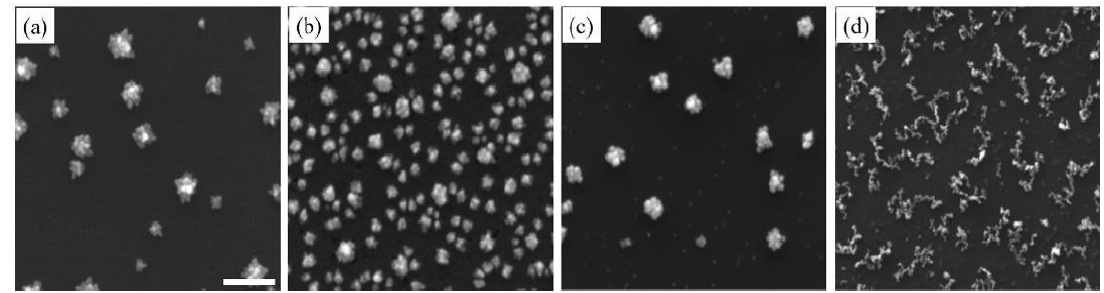
Figure 3. SEM images of Pd nanostructures deposited on Si substrate after the ( a ) first and ( b ) tenth deposition cycles in the presence of sodium dodecyl sulfate (SDS) surfactant, and ( c ) first and ( d ) tenth deposition cycles with cetyltrimethylammonium bromide (CTAB) surfactant. The scale bar is 500 nm.